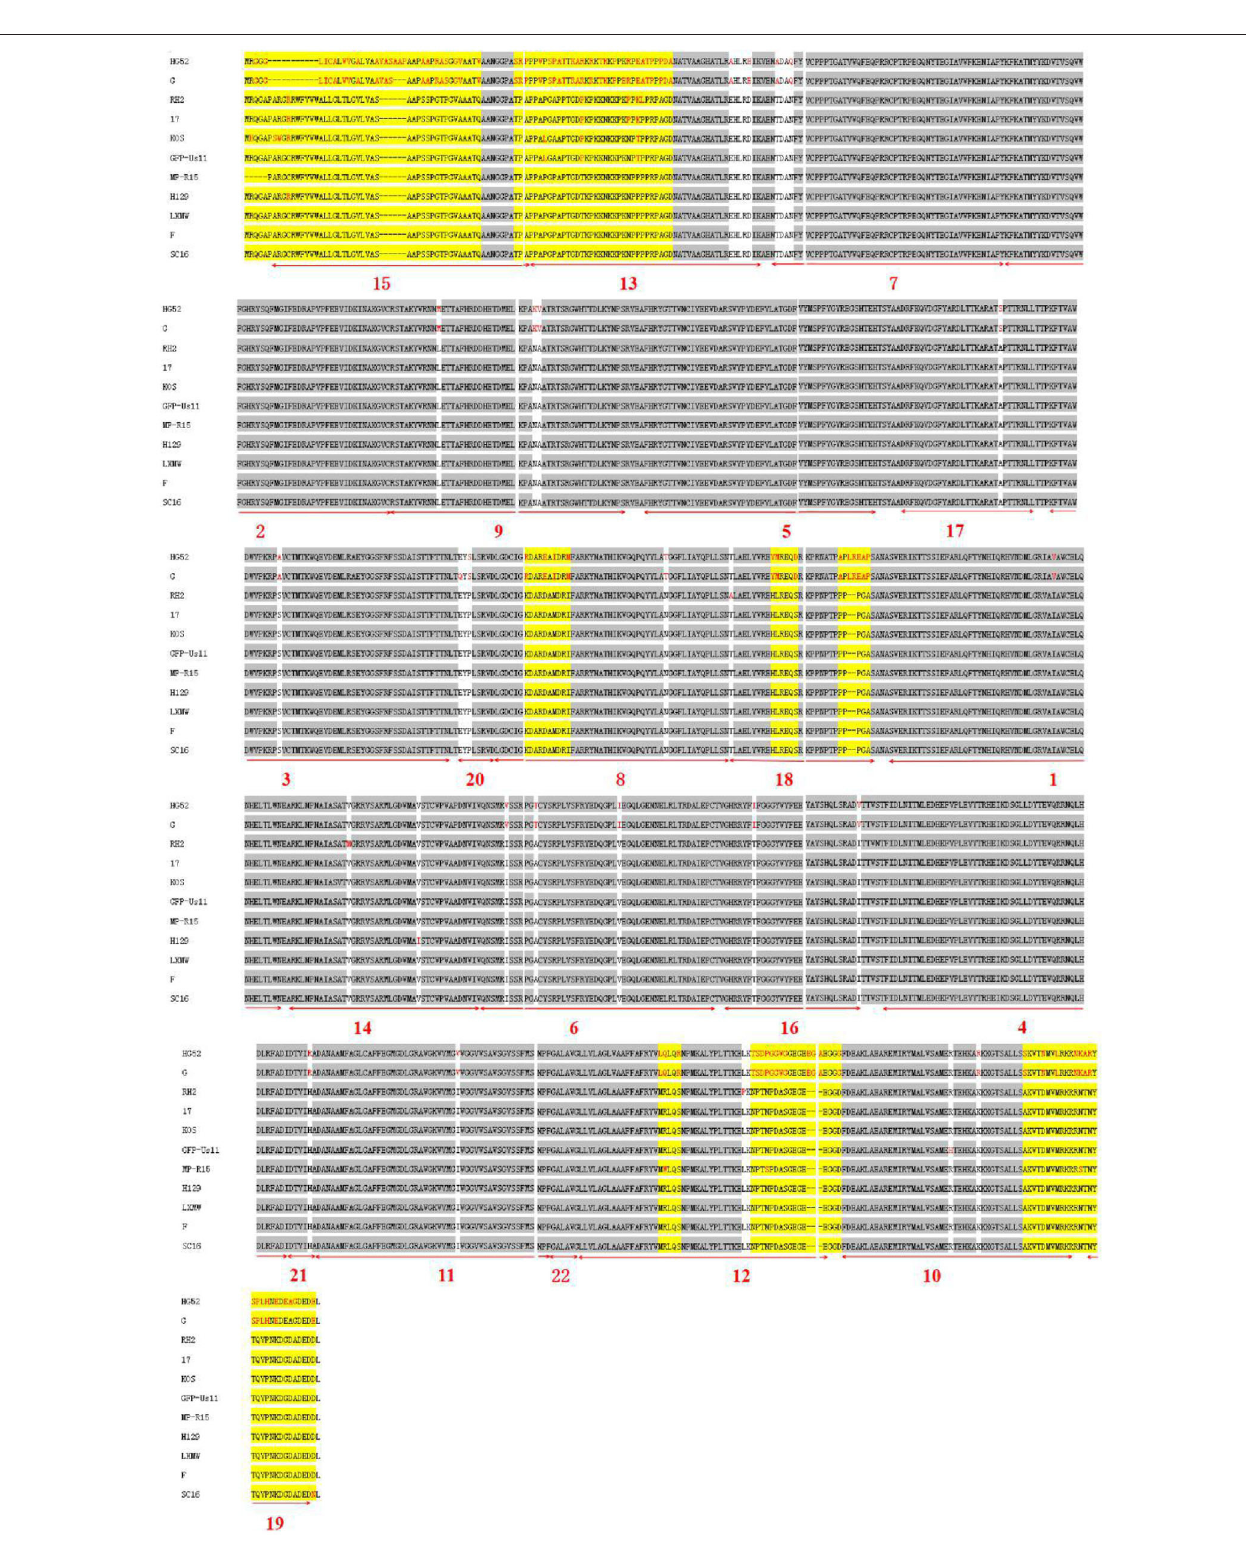
Frontiers in Oncology |